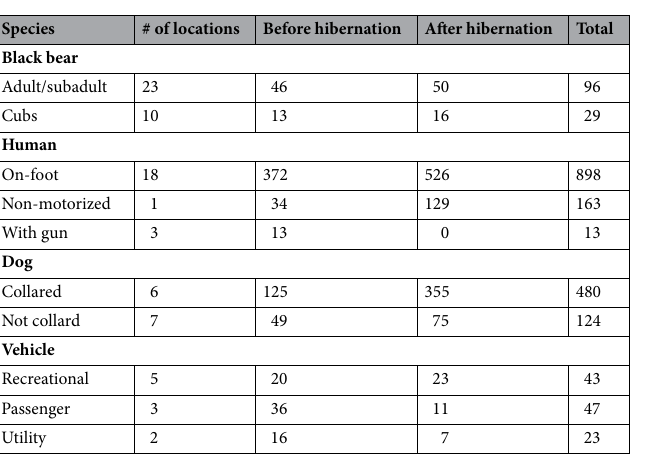
Table 2. Summary of detections for American black bears, humans, domestic dogs, and vehicles before and after hibernation.